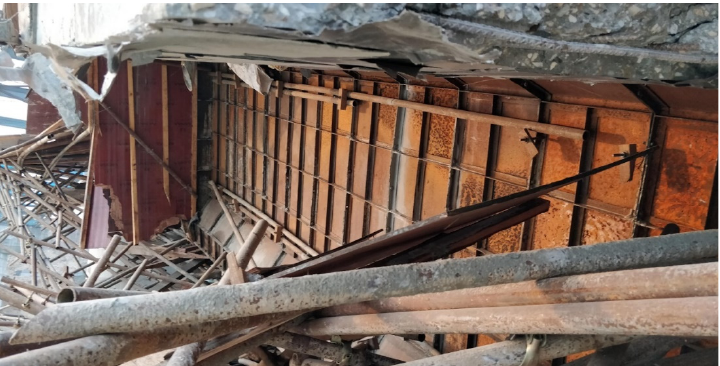
Figure 22. Falsework damage in Span-2; buckling was mostly towards upstream side, indicating damage initiation by settlement of downstream side first.